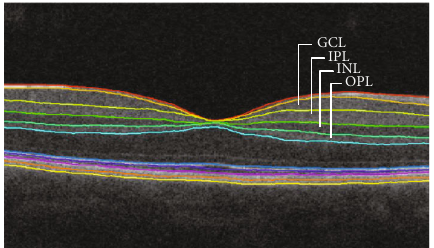
Figure 2: Macular image resulting from the segmentation, identifying the layers analyzed in this study. GCL: ganglion cell layer; IPL: inner plexiform layer; INL: inner nuclear layer; OPL: outer plexiform